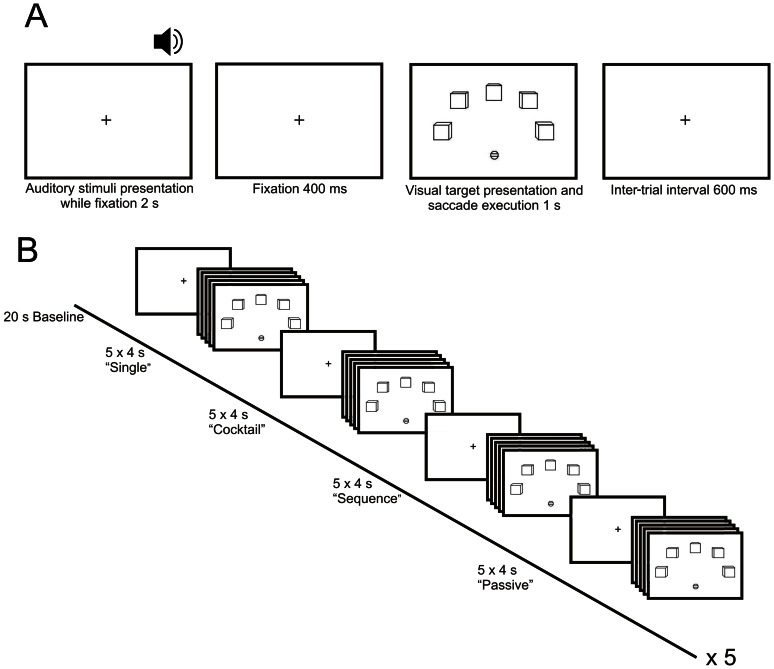
Experimental procedure.(A) Trial structure. Each trial began with the presentation of the auditory stimulus while the subject fixated at the fixation cross for 2 s. The auditory stimulus was followed by a 400 ms interstimulus interval and, subsequently, by the presentation of the visual saccadic-response stimulus for 1 s. The intertrial-interval lasted 600 ms. (B) Experimental run. Each run comprised 5 blocks of each condition, and each block consisted of a sequence of 5 trials. Between blocks, a 20-s rest period was inserted. Conditions were presented in a fixed order: “single” – “cocktail” – “sequence” – “passive”.